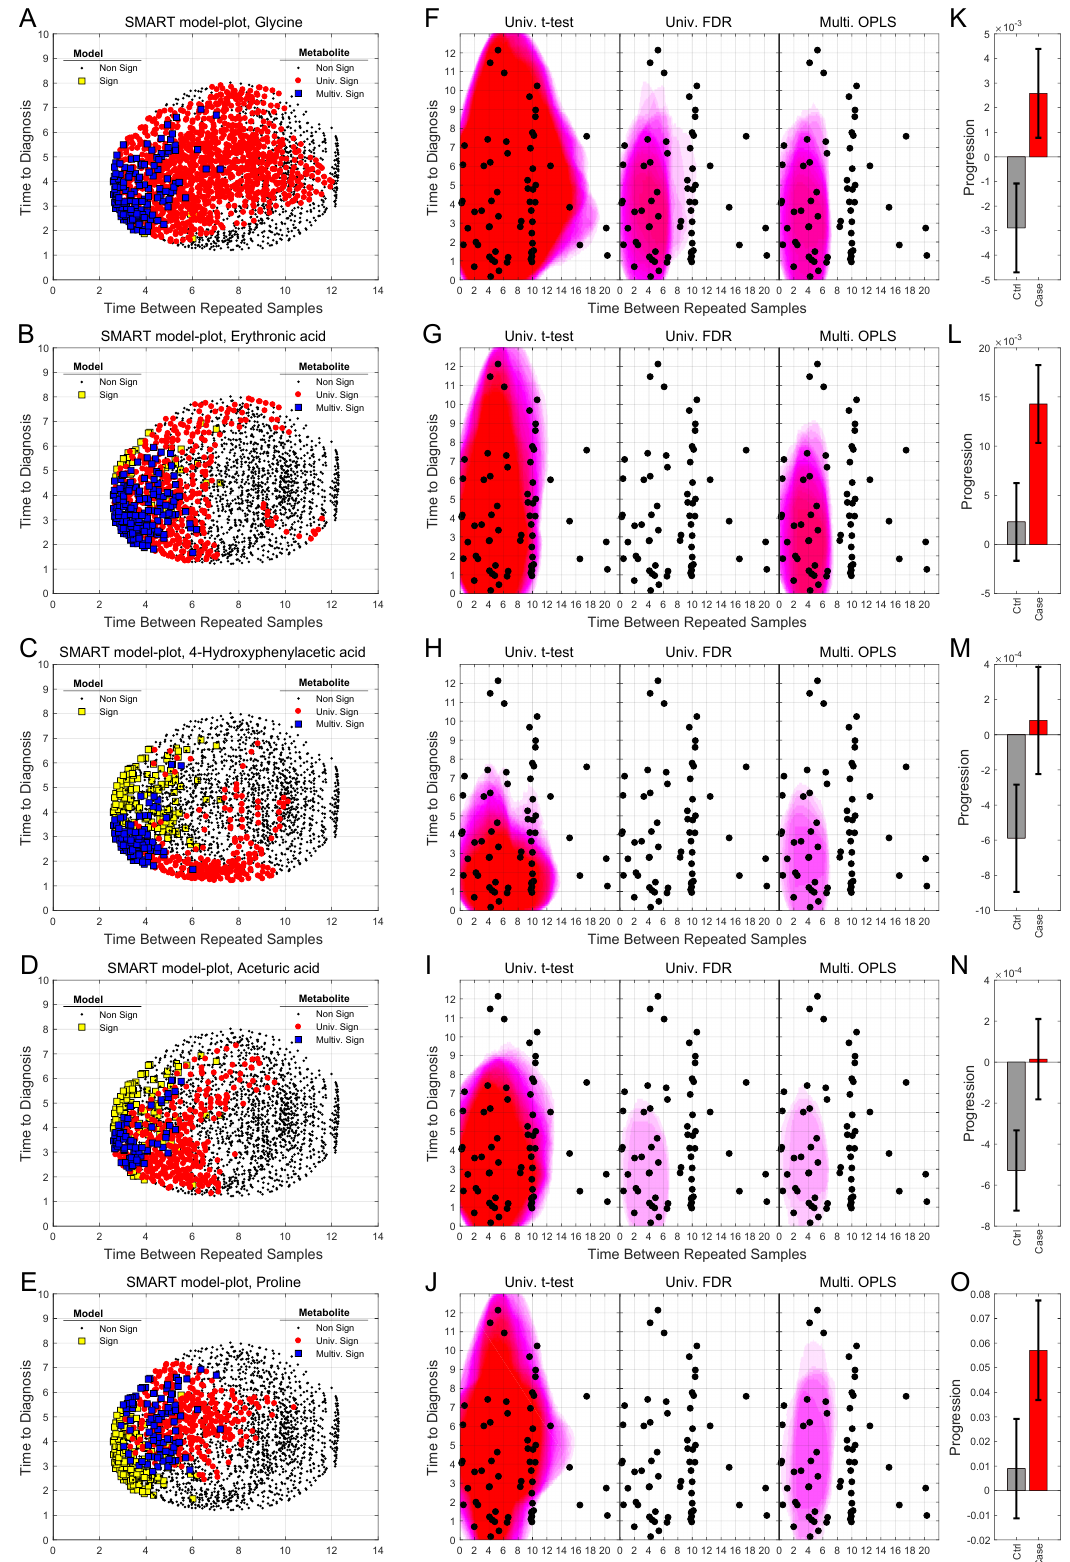
Figure 4. SMART-model and SMART-observation plots, and progression patterns for individual metabolites: glycine ( A , F , K ), erythronic acid ( B , G , L ), 4-hydroxyphenylacetic acid ( C , H , M ), aceturic acid ( D , I , N ) and proline ( E , J , O ). ( A – O ) As described in figure legend